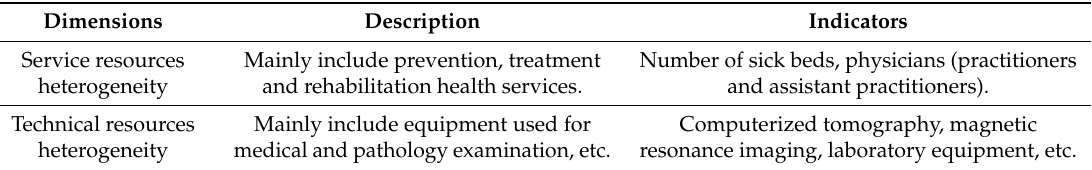
Table 2. Dimensions and interpretation of resource